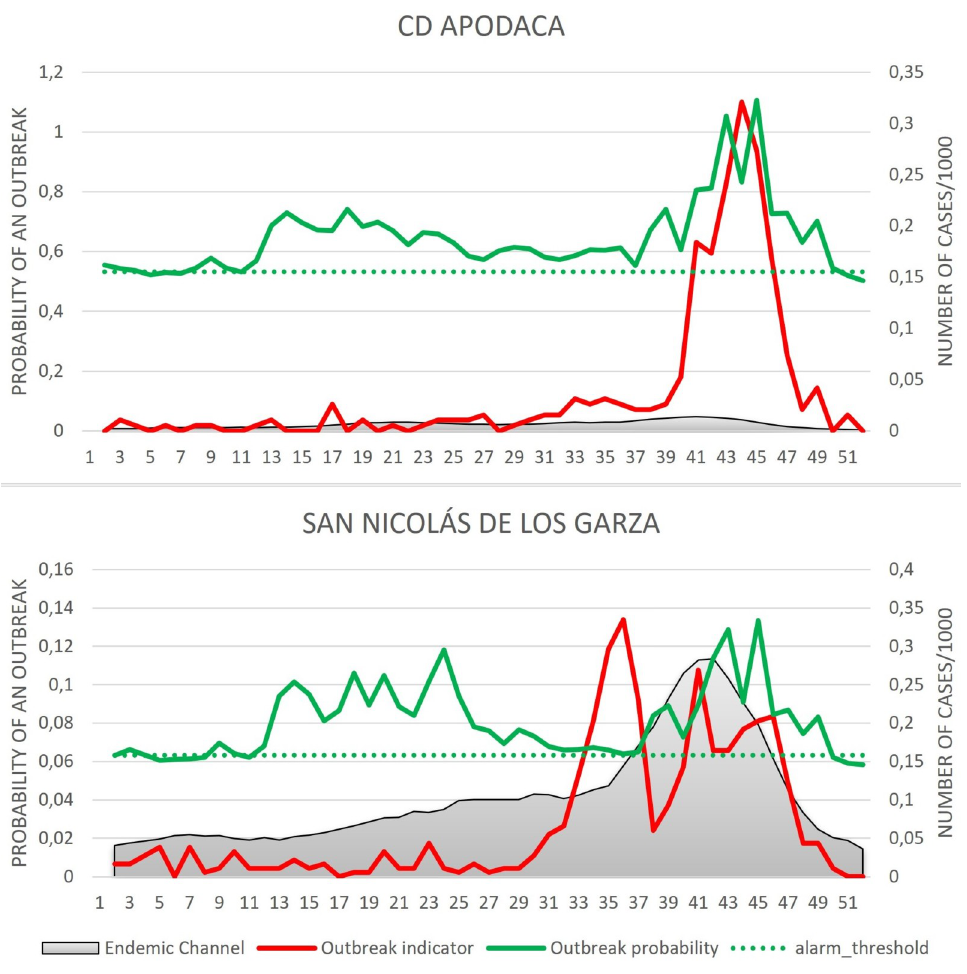
the dotted horizontal line; the outbreak probability (“alarm line”) estimated by the EWS is represented by the green line; the weekly dengue incidence rates is represented by the red